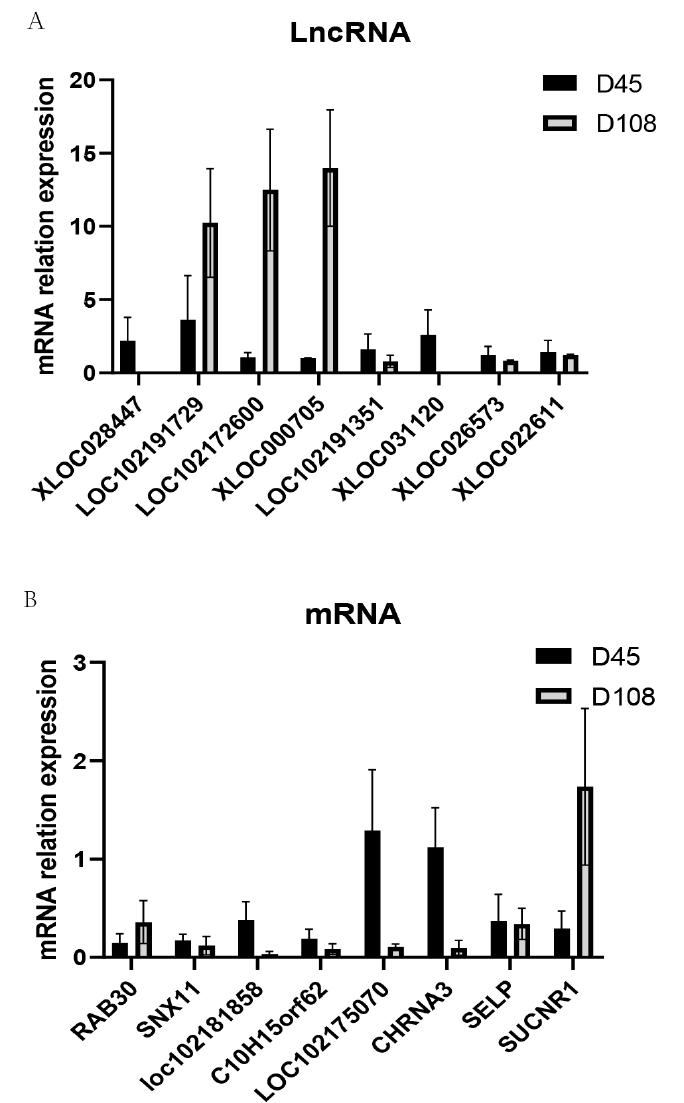
Figure 7. Verification of differentially expressed lncRNAs ( A ) and mRNAs ( B ) by